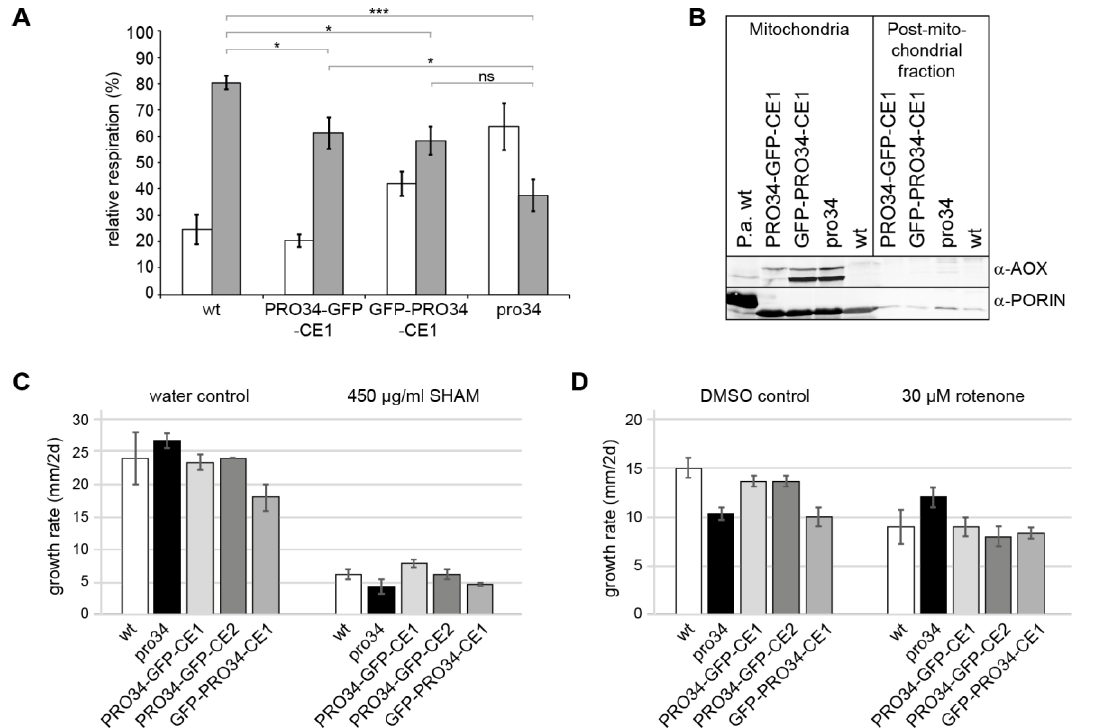
Figure 5. Mutant pro34 respires predominantly via the alternative oxidase pathway. ( A ) Mycelial pieces of S. macrospora wild type (wt), the pro34 mutant and the revertants with GFP-tagged PRO34 were used for oxygen consumption measurements. Shown is the relative respiration rate (oxygen consumption) recorded after the addition of the inhibitors potassium cyanide (KCN; white) or salicylhydroxamic acid (SHAM; gray). For each condition, at least four different mycelial pieces were analyzed: wt KCN, n = 5; wt SHAM, n = 5; pro34 KCN, n = 6; pro34 SHAM, n = 6; PRO34-GFP-CE1 KCN, n = 5; PRO34-GFP-CE1 SHAM, n = 5; GFP-PRO34-CE1 KCN, n = 6; GFP-PRO34-CE1 SHAM, n = 4; Data are mean ± SEM. * p < 0.05; *** p < 0.005; ns, not significant (Mann-Whitney, two- tailed). ( B ) Western blot analysis with an anti- alternative oxidase (AOX) antibody. Protein extracts from mitochondria and post-mitochondrial fractions were analyzed for AOX expression. Detection of the mitochondrial outer membrane protein PORIN served as a control (same as in Figure 3B). ( C ) Vegetative growth on media containing SHAM. Three technical replicates per strain were tested on BMM plates with water or SHAM. ( D ) Vegetative growth on media containing complex I inhibitor rotenone. Three technical replicates per strain were tested on BMM plates with dimethyl sulfoxide (DMSO) or rotenone solubilized in DMSO. KCN, an inhibitor of complex IV; SHAM, an inhibitor of AOX.